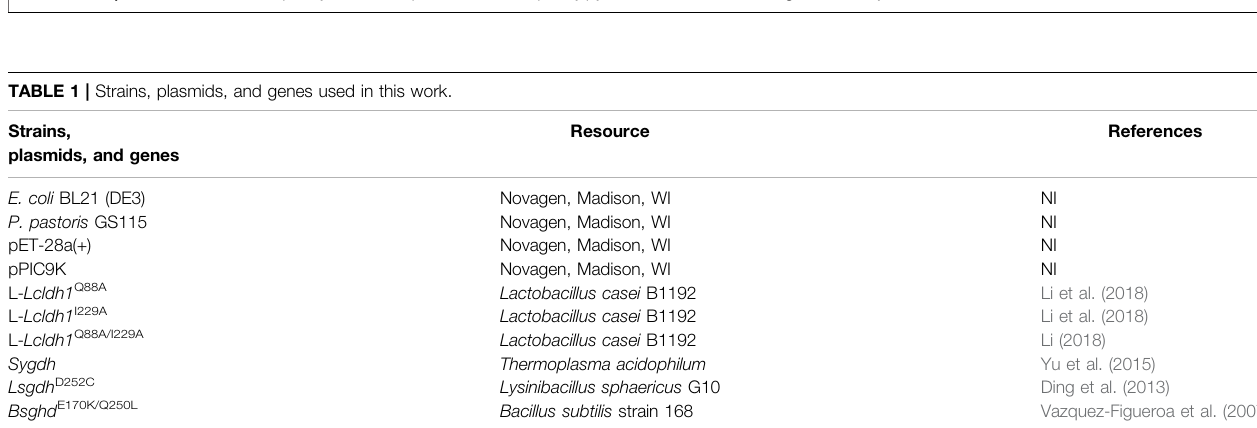
FIGURE. 1 | Schematic view of L-phenyllactic acid production from phenylpyruvic acid with NADH regeneration system.